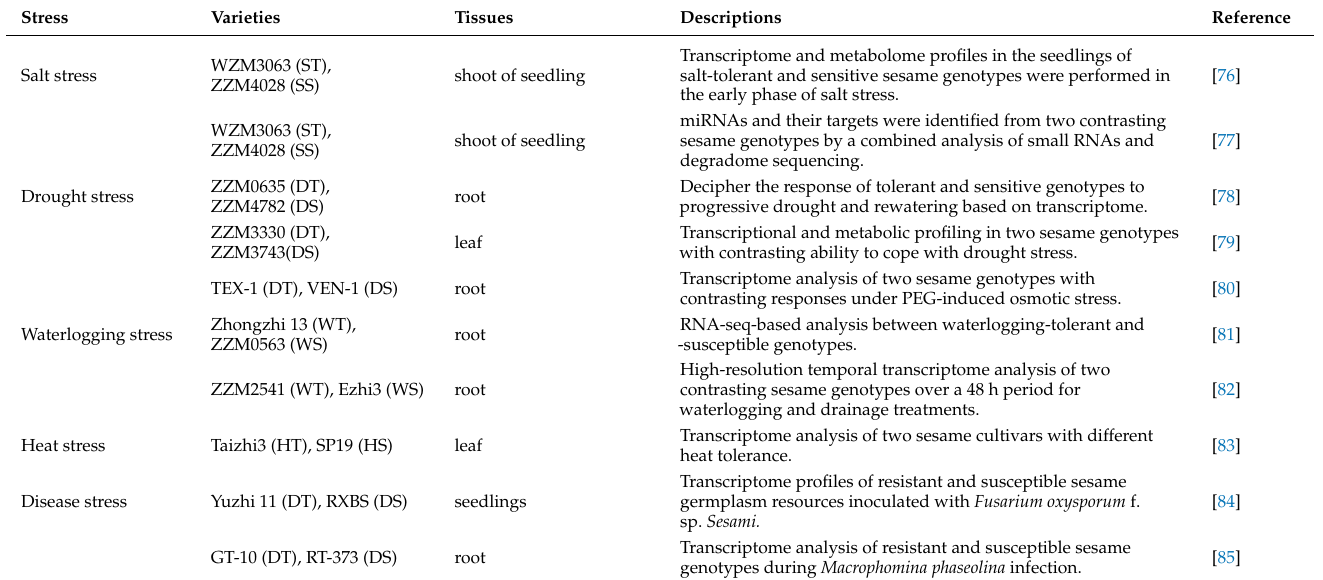
Table 5. The summary of omics studies on stress response in